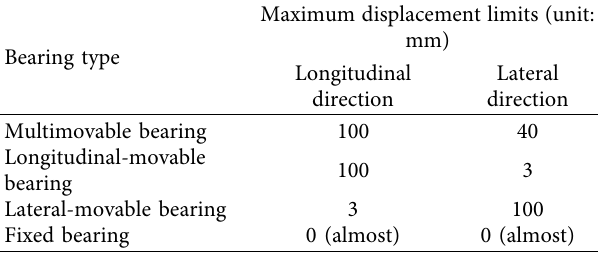
Table 7: Maximum displacement limits of spherical bearings. Bearing type